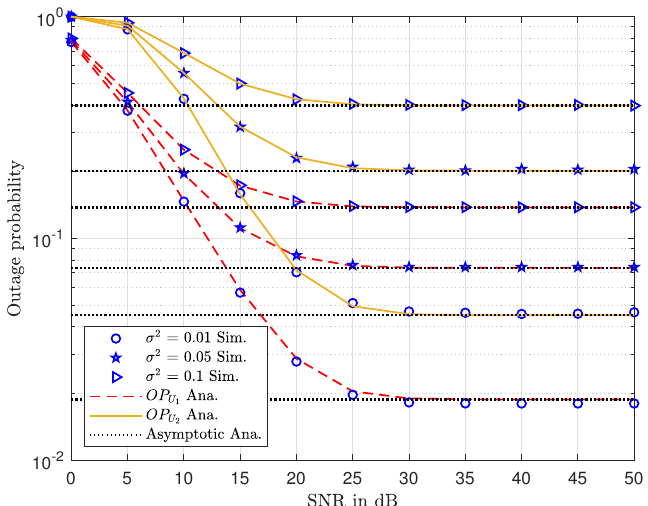
Figure 3. Outage probability of two users vs. SNR with a varying level of CSI imperfection σ with R 1 = R 2 = 0.5 ( BPCU )